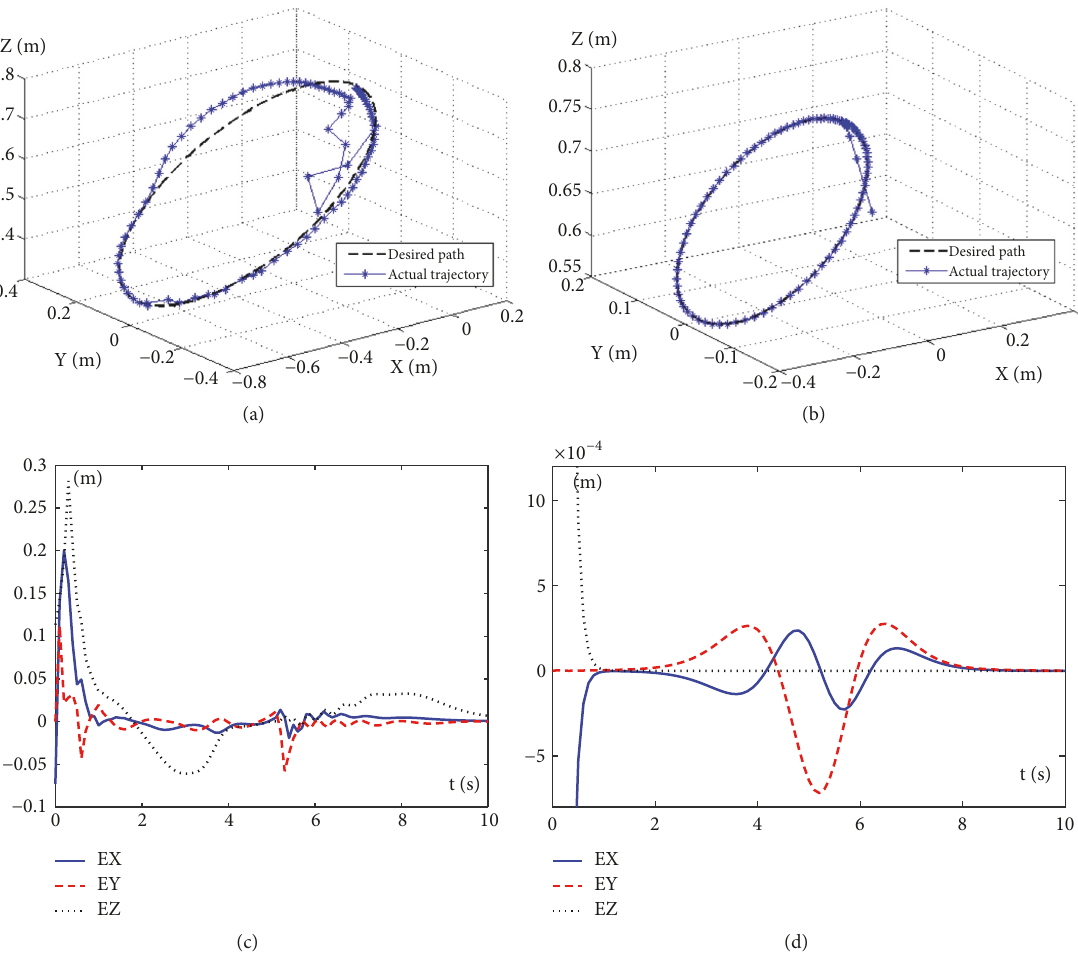
Figure 11: Comparison profiles using different neural optimization scheme. (a) Trajectories of the end-effector with GNN. (b) Trajectories of the end-effector with ZNN. (c) Position error of the end-effector with GNN. (d) Position error of the end-effector with ZNN.